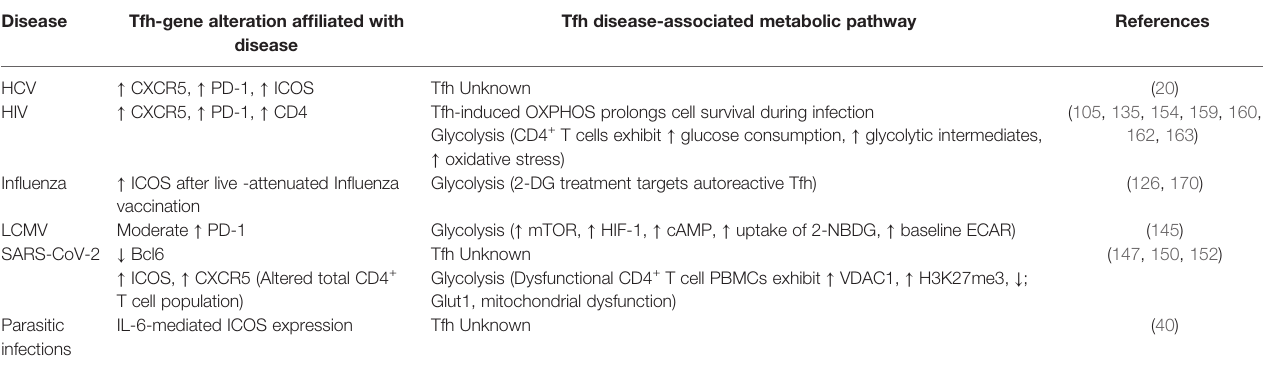
TABLE 1 | Infection-speci fi c metabolic and phenotypic Tfh alterations.